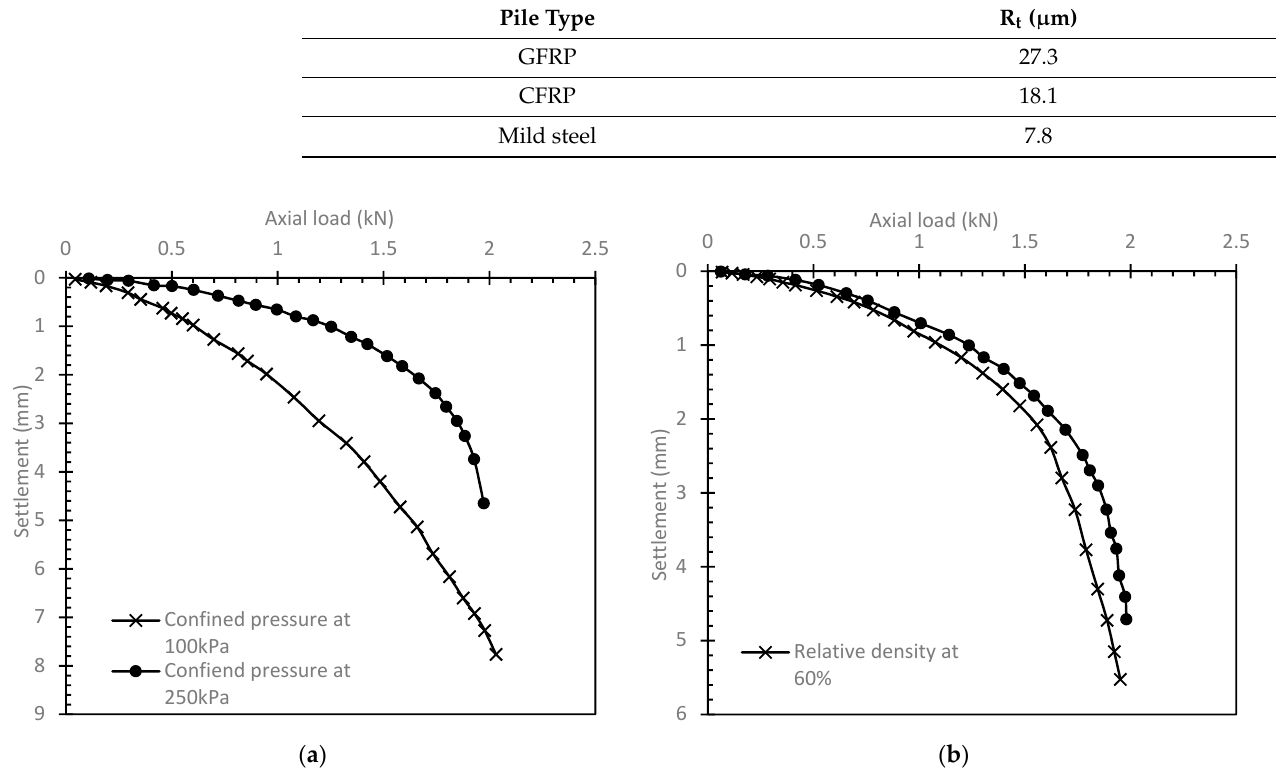
Figure 9. Effect of confined pressure on GFRP piles under an axial load ( a ) and effect of relative density on GFRP piles under an axial load ( b ).